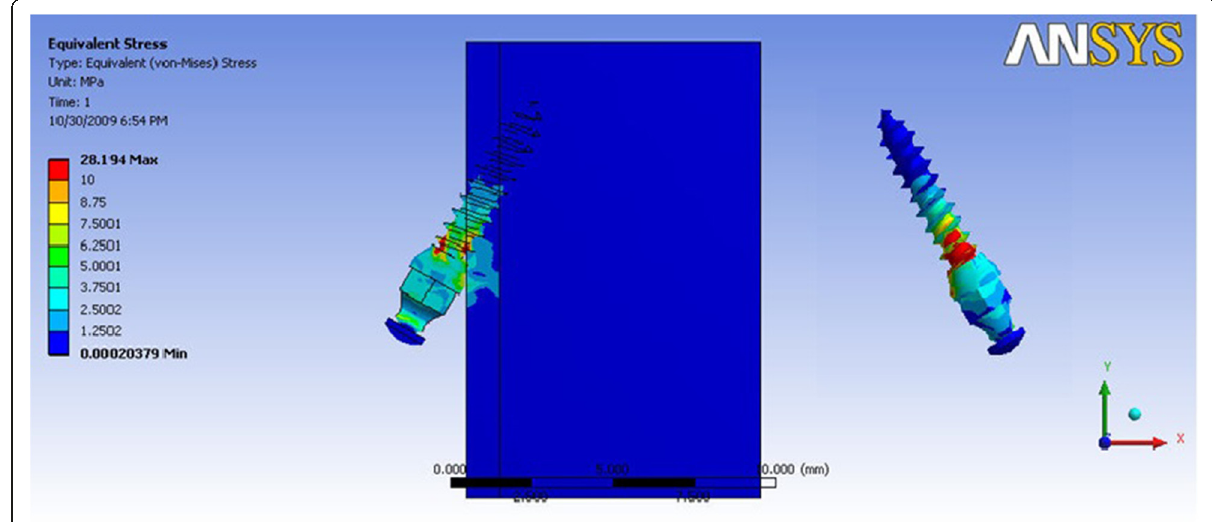
Fig. 5 von Mises stress distribution for mini-implant Group 1a — anterior intrusion and retraction: von Mises stress distribution seen at the bone-implant interface and in the mini-implant alone. Maximum stress seen in the mini-implant was at 28.0